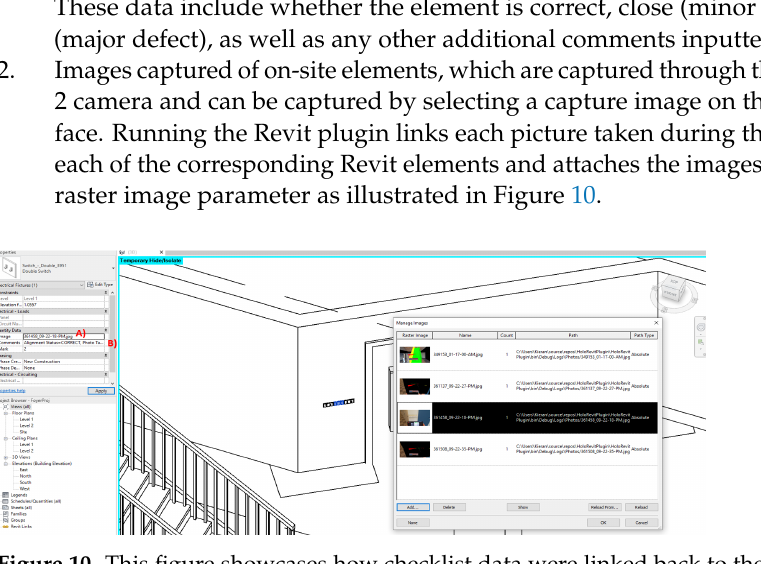
Figure 10. This figure showcases how checklist data were linked back to the original Revit model after running our developed Revit plugin. Image ( A ) shows images captured of elements that are stored as raster images in the given elements “Image” parameter. Image ( B ) shows additional data associated with checklist data that are stored in the elements “Comments”